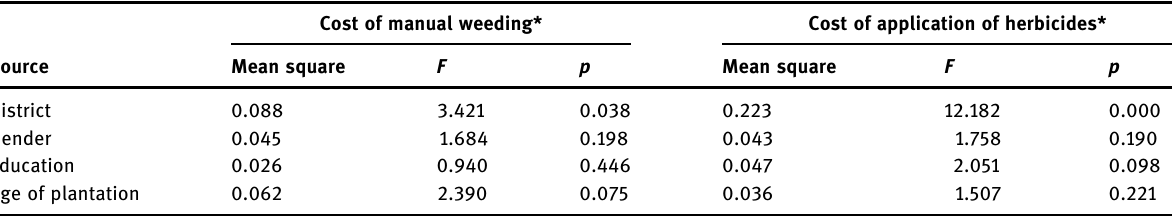
Table 5: Result of one - way ANOVA showing the e ff ect of district, gender, farmers ’ education level, and age of plantation on average cost of manual weeding and cost of application of herbicides per hectare Cost of manual weeding* Cost of application of